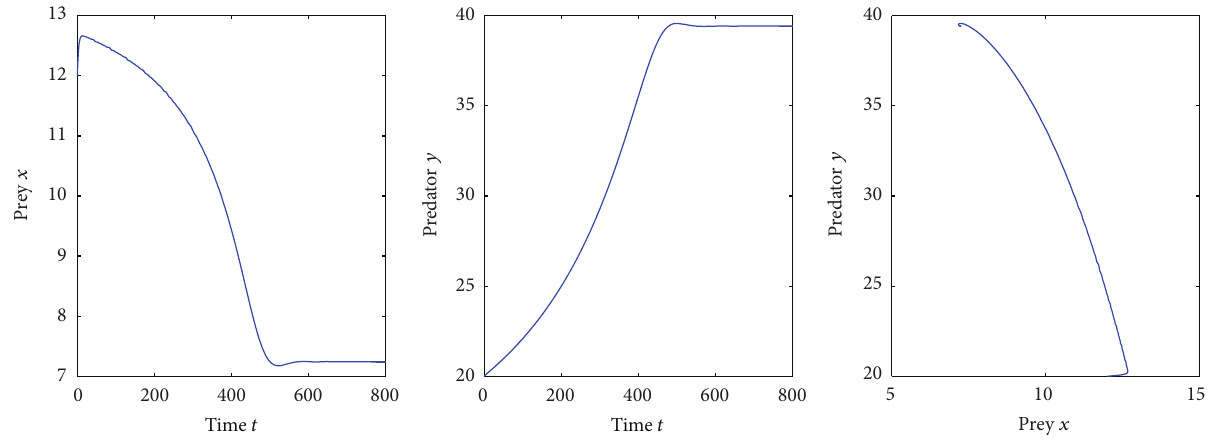
Figure 9: The time series and the portrait phase of the system (1) when 𝑟 = 0.5 , 𝐾 = 15 , 𝑎 = 100 , 𝜇 = 0.8 , 𝐷 = 0.038 , and (𝑥(0),𝑦(0)) = (12, 20)